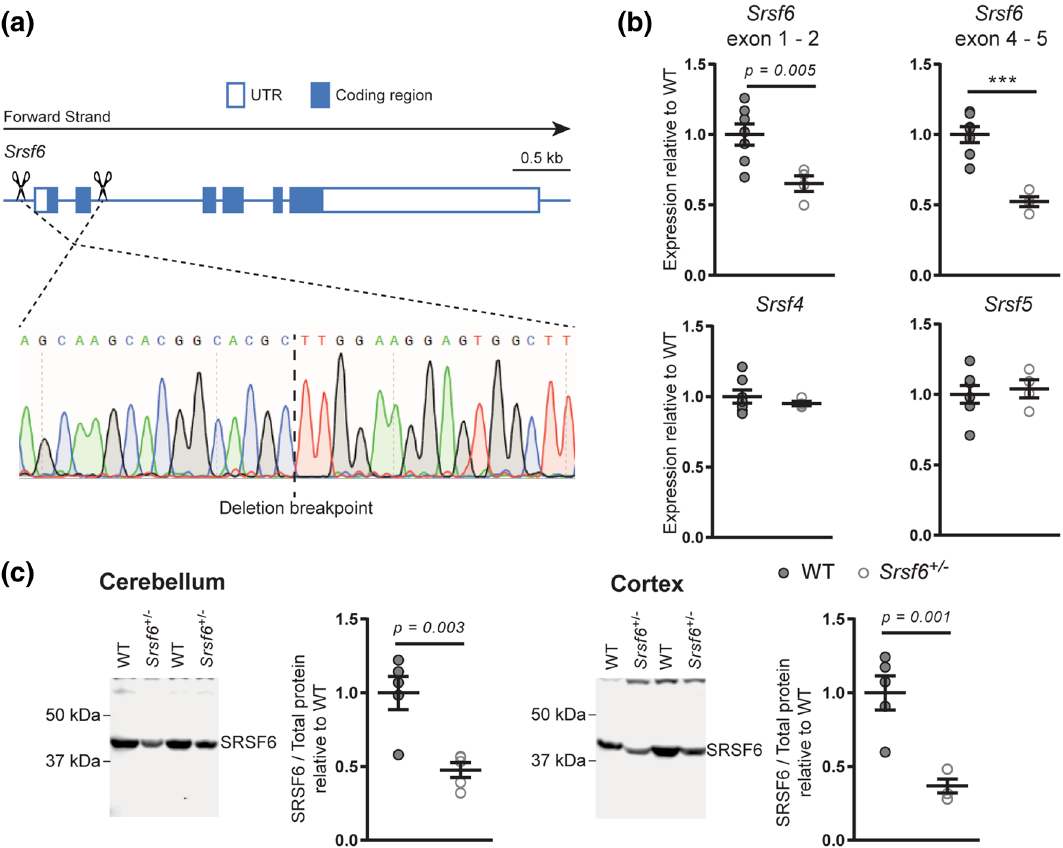
Figure 1. Characterisation of the Srsf6 knockout mouse line. ( a ) Schematic of mouse Srsf6 with scissors denoting approximate Cas9 cleavage sites used to generate the knockout allele. Sanger sequencing was used to confirm the deletion breakpoint for the Δ990 bp line. UTR untranslated region. ( b ) qPCR analysis showed Srsf6 mRNA levels to be 50% of WT whereas, Srsf4 or Srsf5 levels were unchanged in cortex from 2 month old Srsf6 + /− Δ990 mice. n = 7 WT and 4 Srsf6 + /− mice. ( c ) Western blot analysis showed a 50% reduction in SRSF6 in cerebellum and cortex from 2 month old Srsf6 + /− mice compared to WT littermates. See Supplementary Fig. S7 for uncropped blots and total protein loading controls. n = 5/genotype. Statistical analyses were by unpaired Student’s t -tests. Test statistics can be found in Supplementary Table S4. WT wild type.